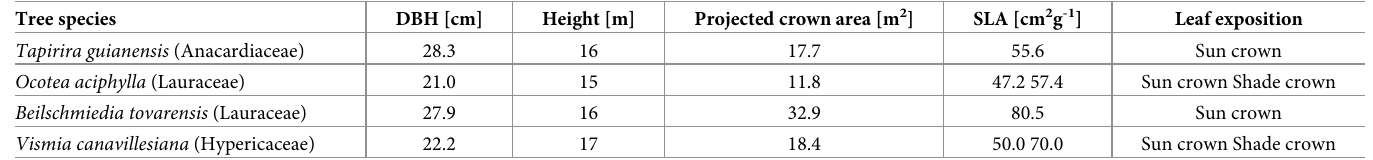
Table 1. Characterization of the investigated trees: Height, diameter at breast height (DBH), projected crown area, specific leaf area (SLA), and leaf exposition. SLA data from personal communication by Ju¨rgen Homeier (Dept. Resource Management, University of Applied Sciences and Arts (HAWK) Go¨ttingen, Germany). Tree species DBH [cm] Height [m] Projected crown area [m 2 ] SLA [cm 2 g -1 ] Leaf